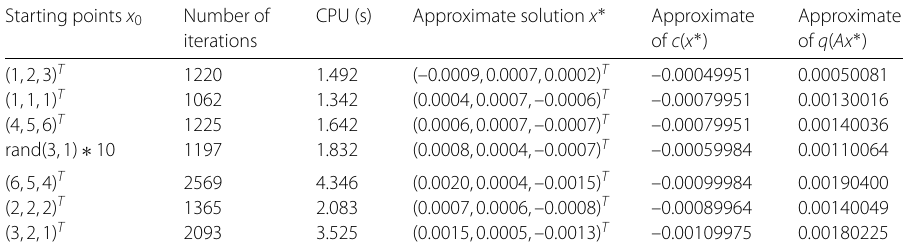
Table 5 Results for Example 5.4 using Algorithm in Corollary